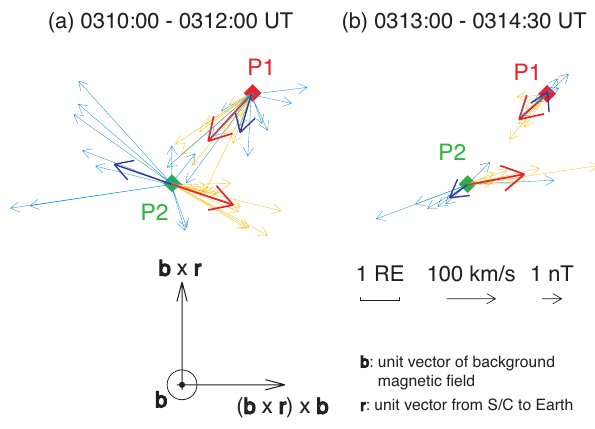
Fig. 6. Magnetic field variations (blue thin arrows) and plasma flow patterns (orange thin arrows) at (a) 03:10:00–03:12:00UT and (b) 03:13:00–03:14:30UT in the plane perpendicular to the local magnetic field (see Sect. 4. for detailed descriptions of the coor- dinate system). Diamonds represent spacecraft positions. Red and blue thick arrows indicate the average of the corresponding plasma flows and magnetic field variations,